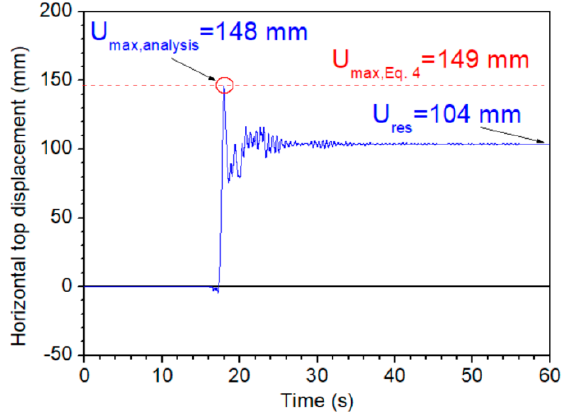
Figure 13. Time history of top displacement of Frame A4 under the Bam (26/12/2003) earthquake.